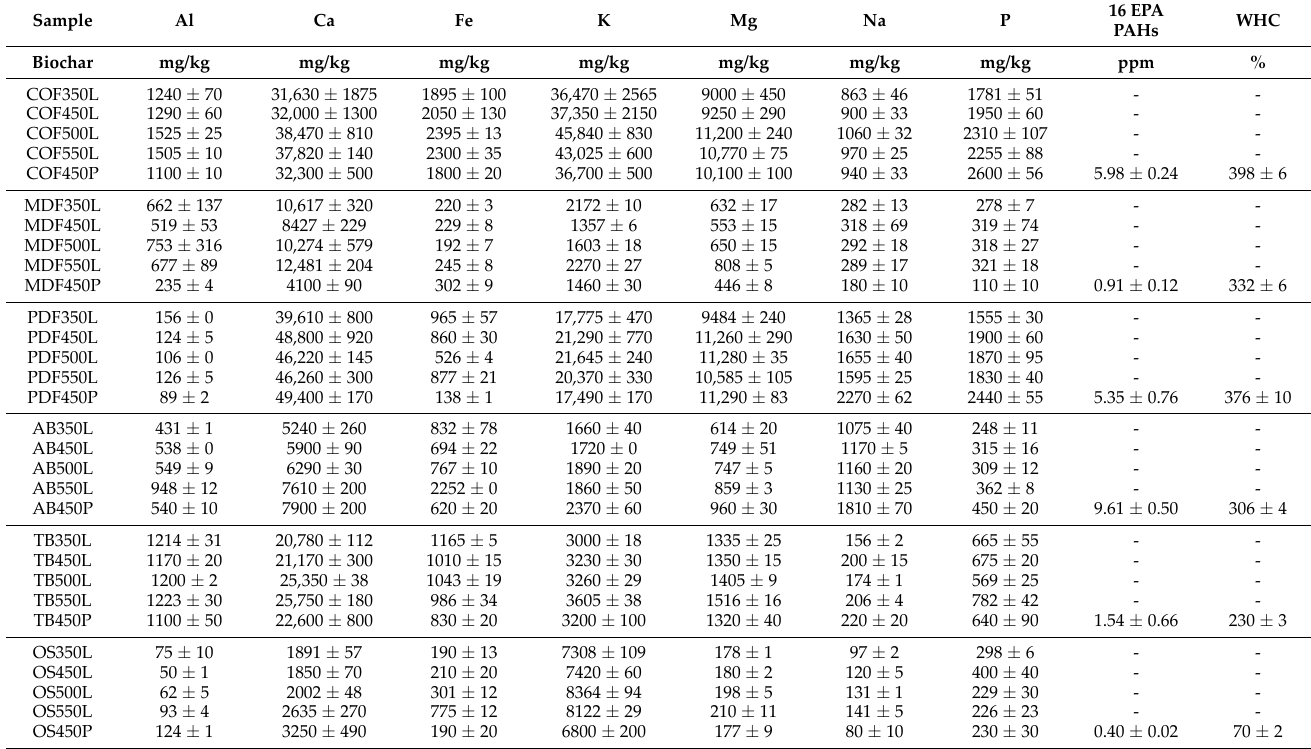
Table 4. Elemental composition, content of 16 EPA polycyclic aromatic hydrocarbon (PAHs), and water holding capacity (WHC) of the biochars. The blanks (‑) in the 16 EPA PAHs and WHC indicate that these samples were not measured. L = lab‑scale reactor, P = pilot‑scale reactor, COF = coffee husks, MDF = medium‑density fiberboard, PDF = palm date fronds, AB = AB wood waste, TB = tree bark, and OS = olive